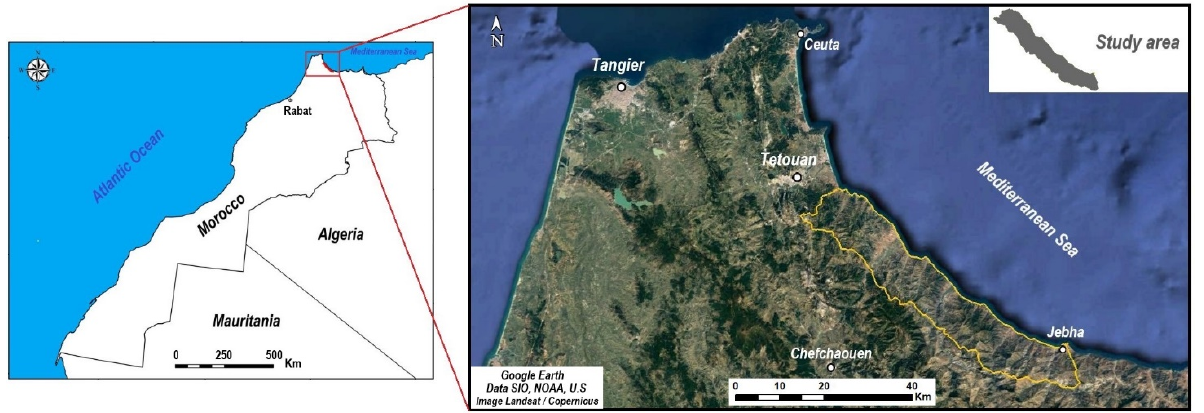
Figure 1. Geographical location of the study area (within the yellow line).